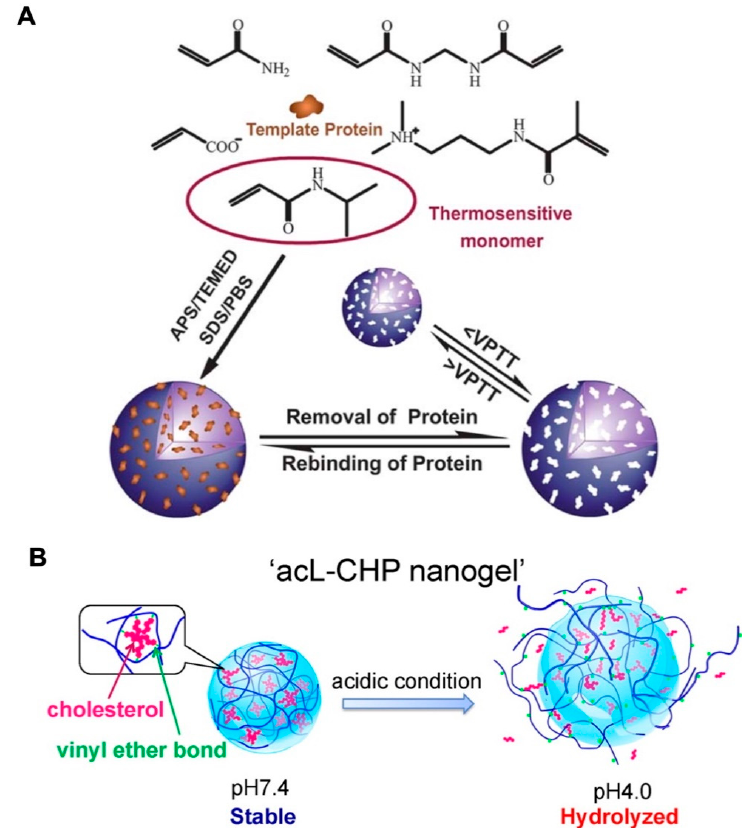
Figure 3. ( A ) Schematic illustration of the aqueous imprinting method for protein-loaded thermoresponsive nanogels (with APS as an initiator and sodium dodecyl sulfate (SDS) as an emulsifier). The change in temperature below or above VPTT enabled the removal or rebinding of protein. Republished with permission of Royal Society of Chemistry, from [Soft Matter, 2013, 9, 3840– 3850. Edition Number 38, Copyright (2013)]; permission conveyed through Copyright Clearance Center, Inc. ( B ) By hydrolysis of cholesteryl vinyl ether bond at pH 4.0, the acid-labile cholesteryl-bearing pullulan nanogels (acL-CHP) resulted in swelling-collapse and presented the acid-triggered drug release. Adapted with permission from (Biomacromolecules 2013, 14, 56-63). Copyright (2013) American Chemical Society.